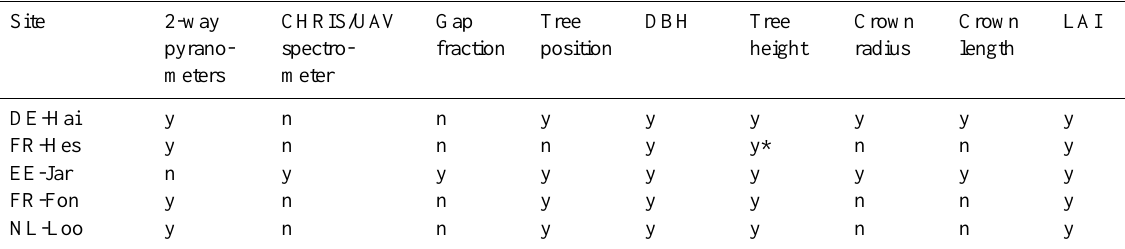
Table 3. Data availability for site level validation. The symbol (*) indicates that for FR-Hes tree height was calculated from provided site-specific allometric relationship. Gap Tree DBH Tree Crown Crown CHRIS/UAV Site 2-way fraction position height radius length spectro- pyrano- meter meters